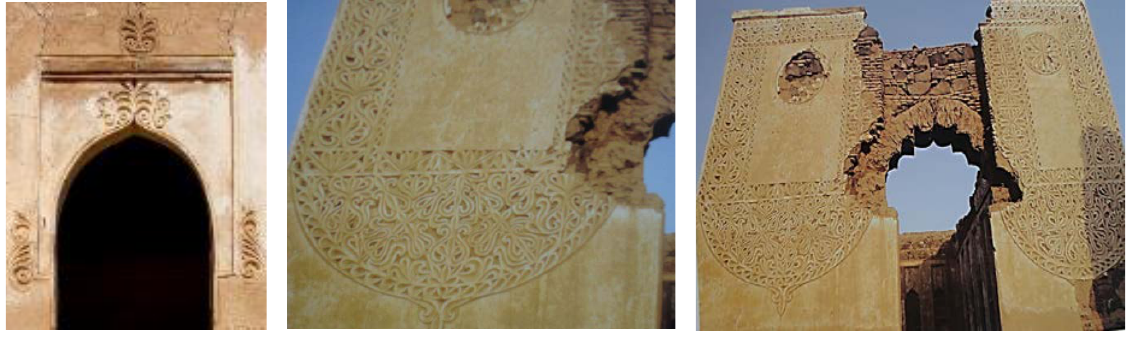
(Figure. 15) A city gate at Sebya, Idrisid Era 14 th AH/20 th